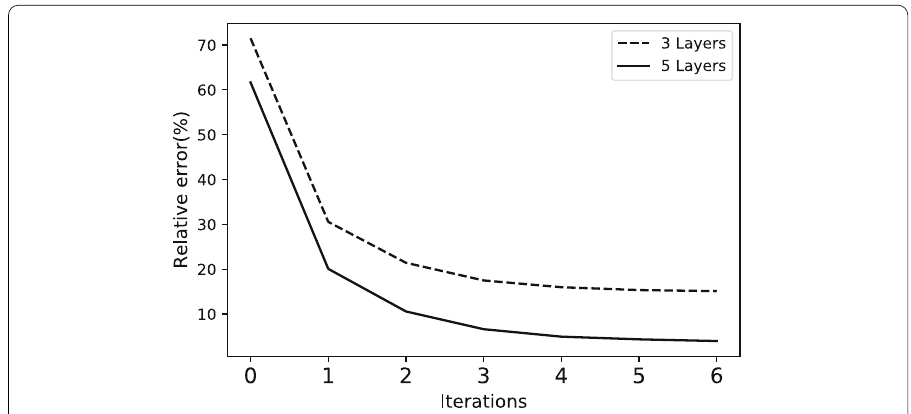
Fig. 10 Total relative error evolution for 3 and 5 layers discretizations